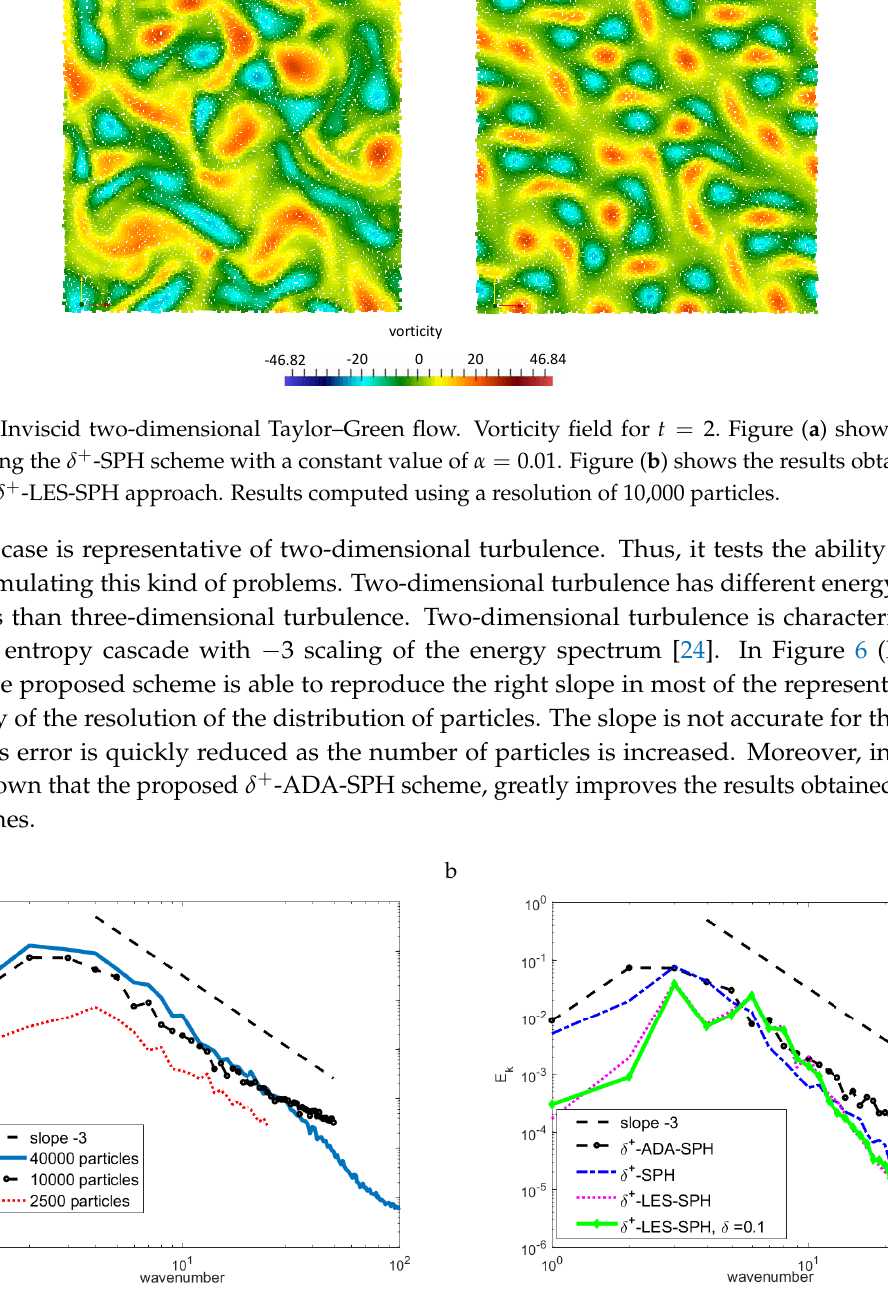
Figure 6. Inviscid two-dimensional Taylor–Green flow. Figure ( a ): Energy spectrum obtained using the proposed δ + -ADA-SPH method with different particle resolutions . Figure ( b ): comparison of the results using different δ + -SPH schemes using a resolution of 10,000 particles ( right